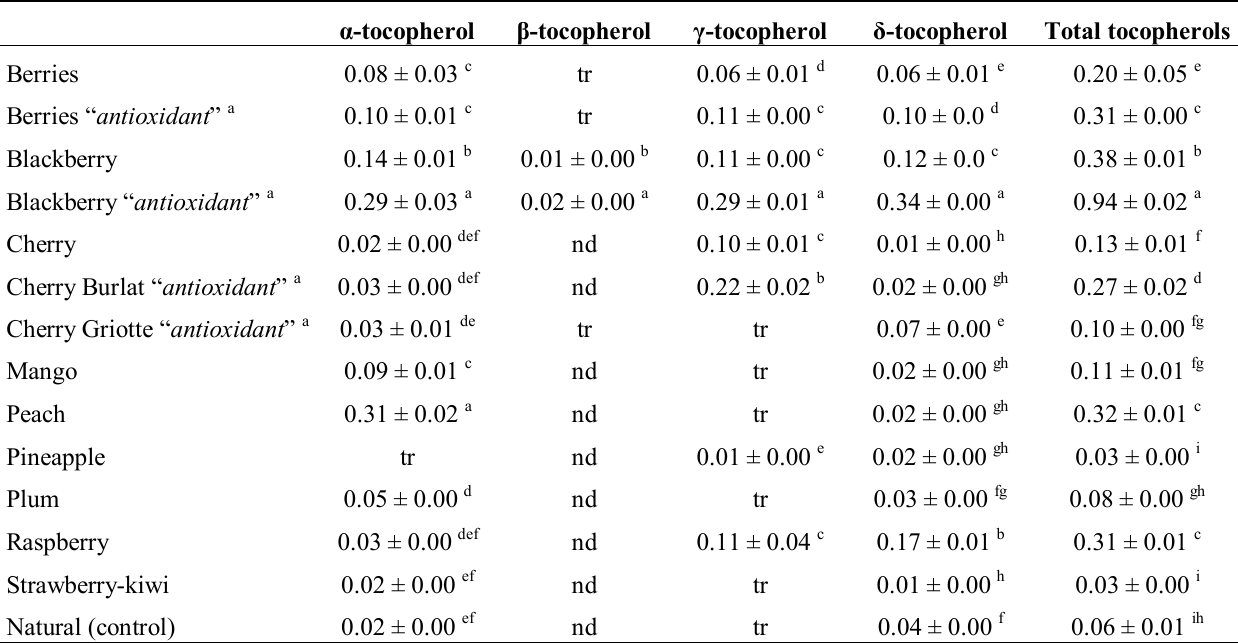
Table 4. Tocopherols composition of the studied yogurts obtained by chromatographic analysis (mean ± SD).